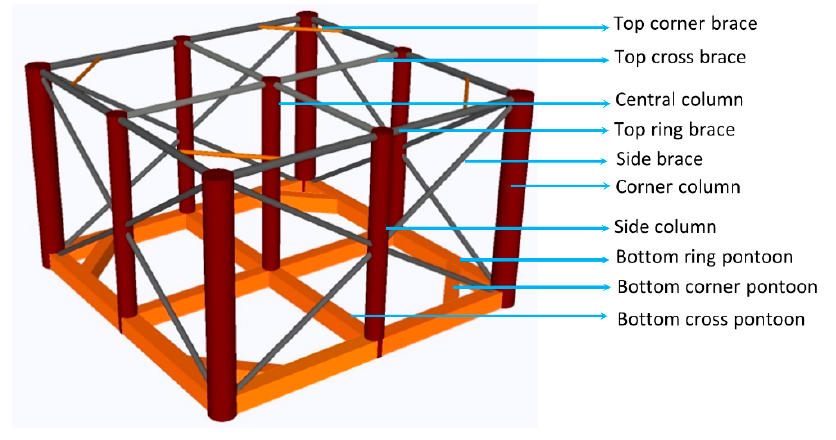
Figure 2. Steel fishing cage.